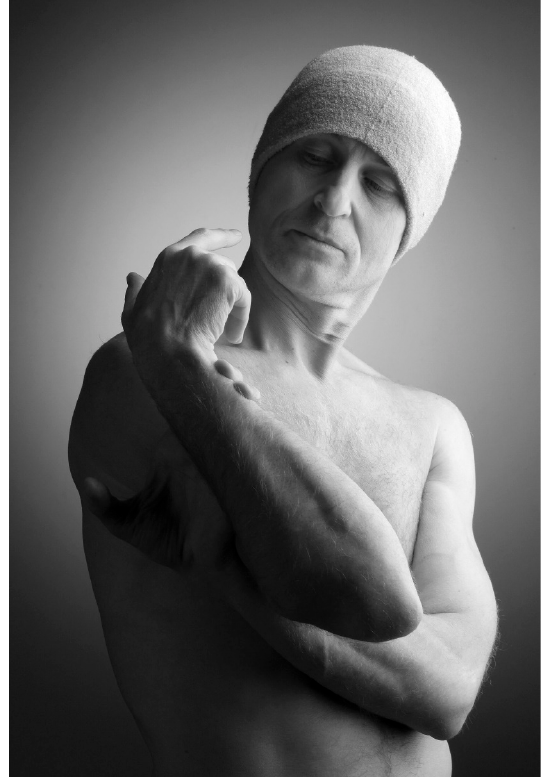
Figure 3. Pál Frenák—© Zsolt Hamarits. Figure 3. P á l Fren á k—© Zsolt